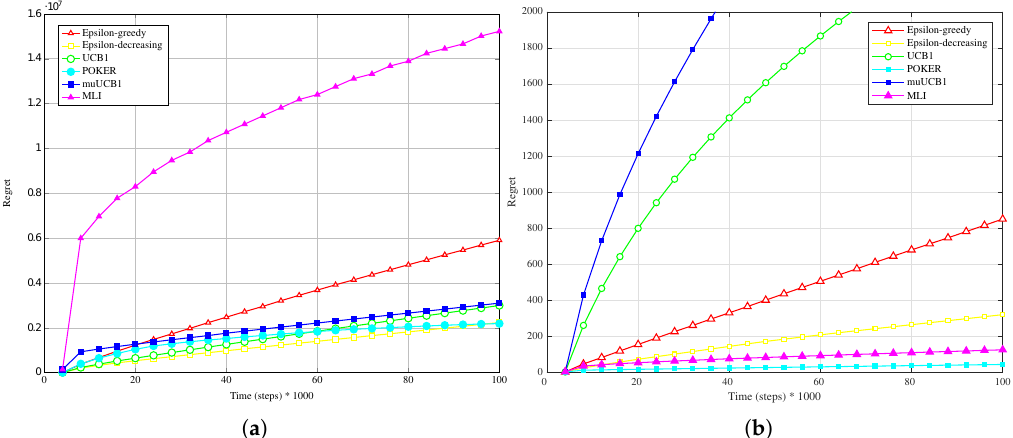
Figure 13. Performance in terms of regret of the six considered algorithms, with real captured data used as reward and T U / T M = 10. ( a ) linear conversion; ( b ) logarithmic